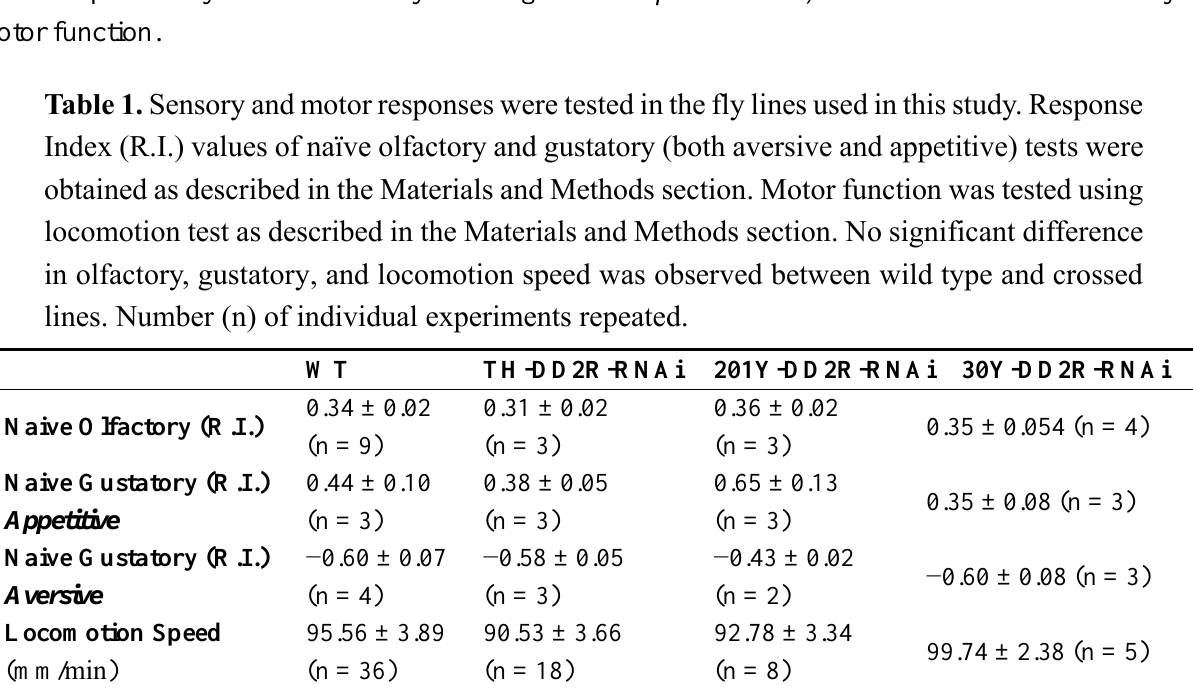
Table 1. Sensory and motor responses were tested in the fly lines used in this study. Response Index (R.I.) values of naïve olfactory and gustatory (both aversive and appetitive) tests